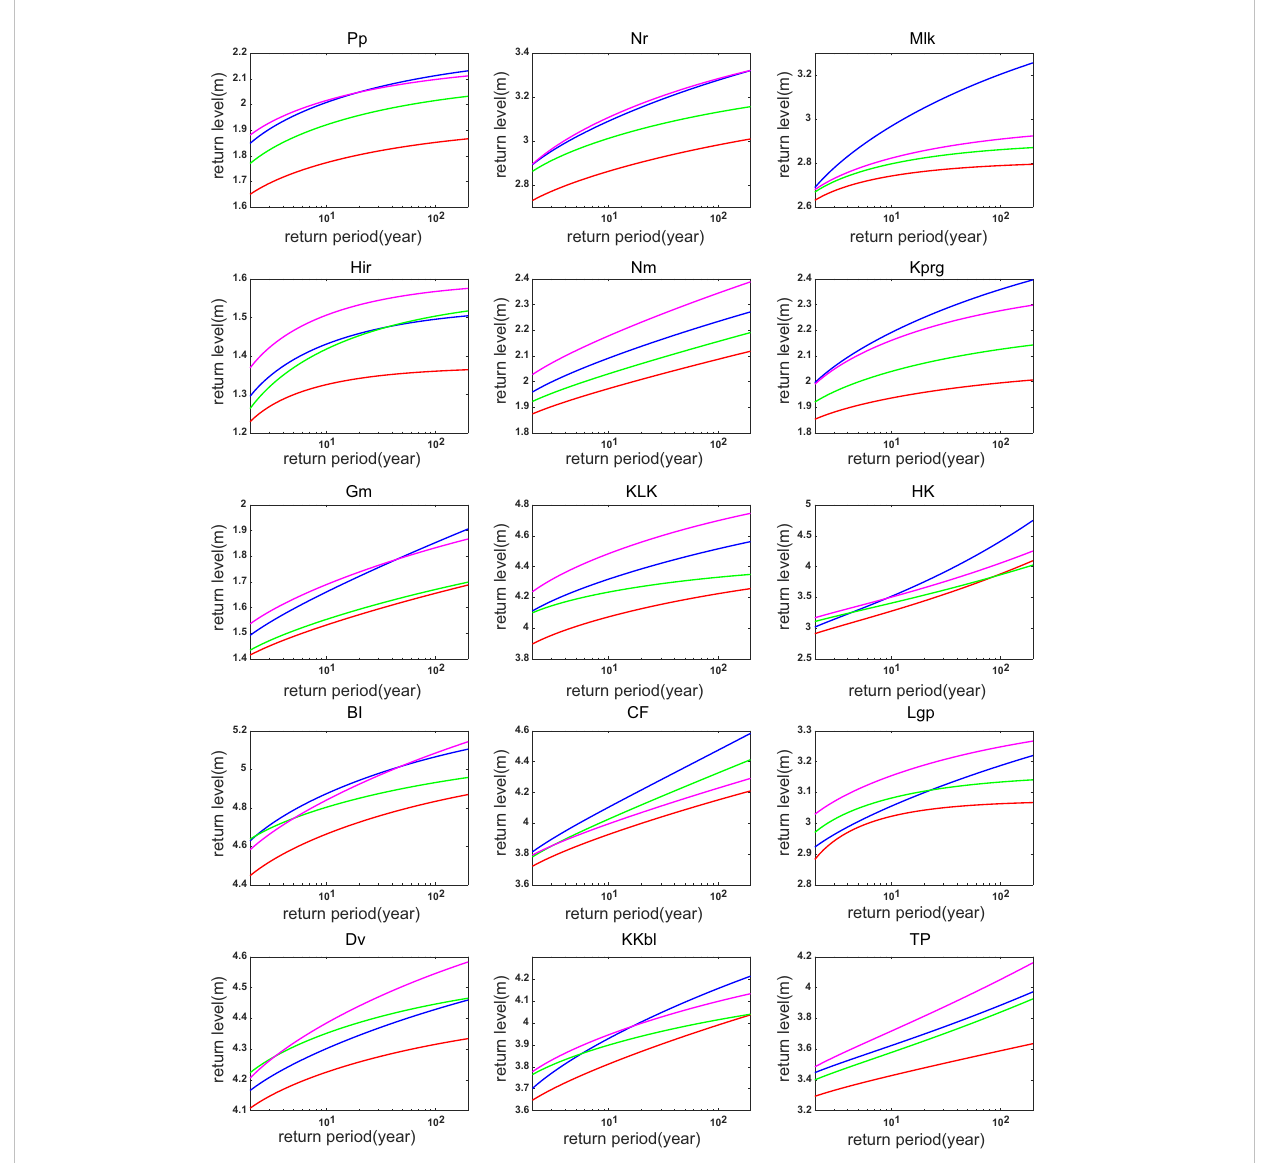
FIGURE 5 Return levels of the ESL at present (red line) and under the 2.0°C warming scenario: MIROC6 (blue line), CMCC-ESM2 (green line), EC-Earth3 (pink